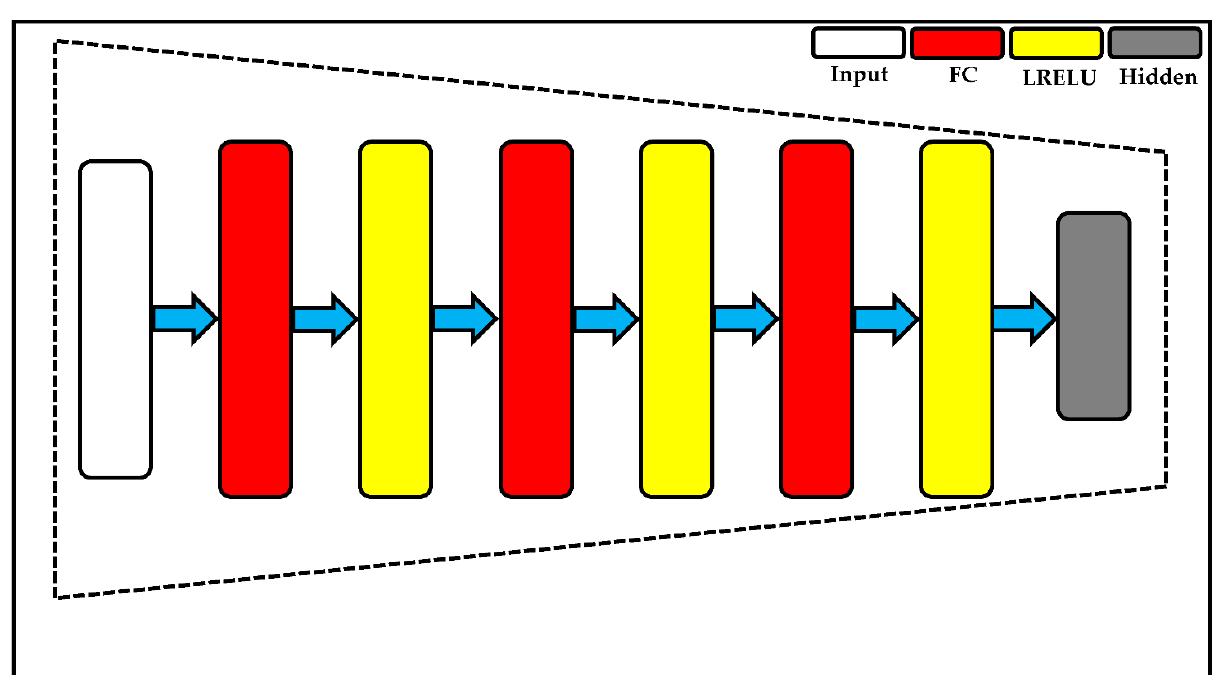
Figure 12. Composition of the encoder.